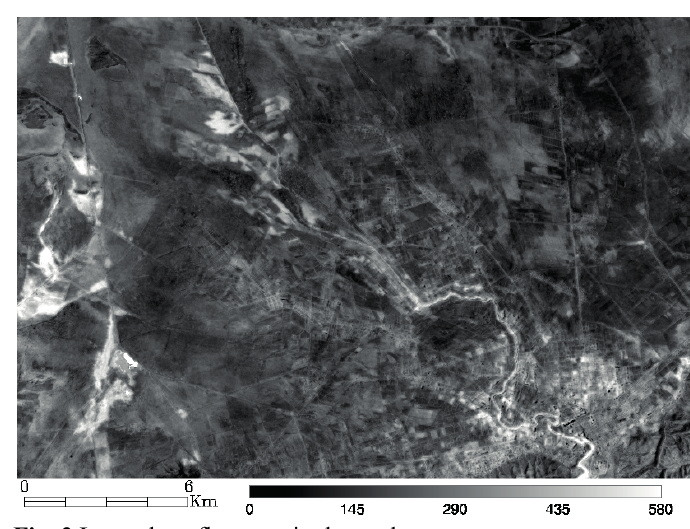
Fig. 3 Latent heat flux map in the study area.